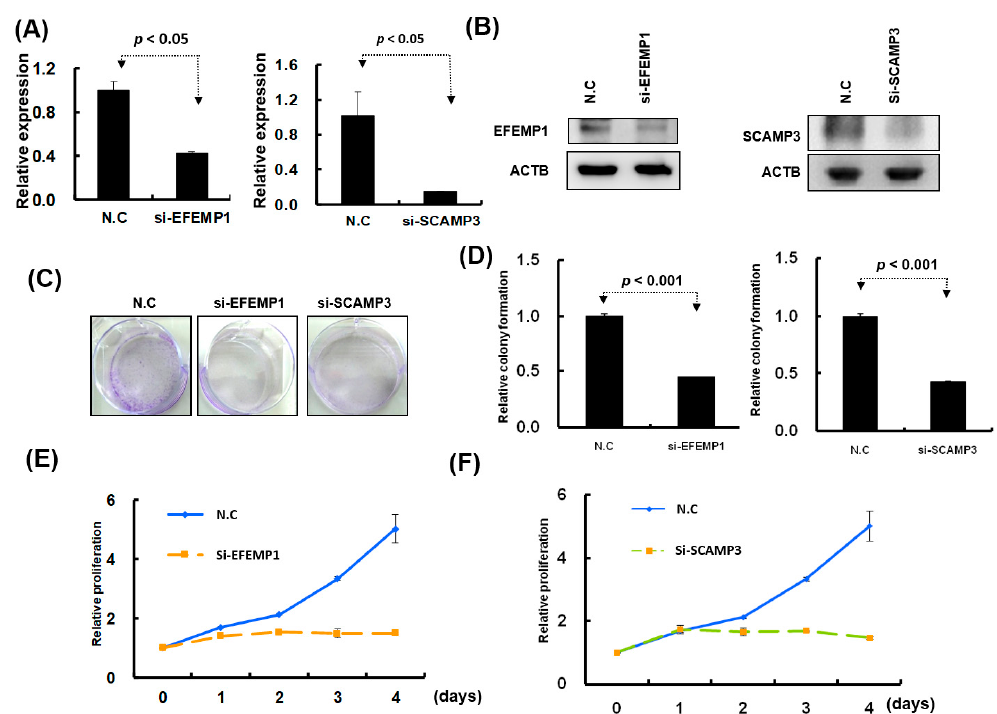
Figure 8. Knockdown of EFEMP1 and SCAMP3 expression significantly inhibited melanoma cell growth. ( A ) and ( B ): After siRNA transfection, the expression levels of EFEMP1and SCAMP3 were examined through real-time PCR and Western blotting. ( C ) and ( D ): Colony formation assay was examined in A2058 cells with EFEMP1 and SCAMP3 knockdown; and the relative colony formation ability was quantified using OD595 nm. ( E ) and ( F ): Cell proliferation was assessed in A2058 cells with EFEMP1 and SCAMP3 knockdown using the CellTiter-Glo One solution assay.